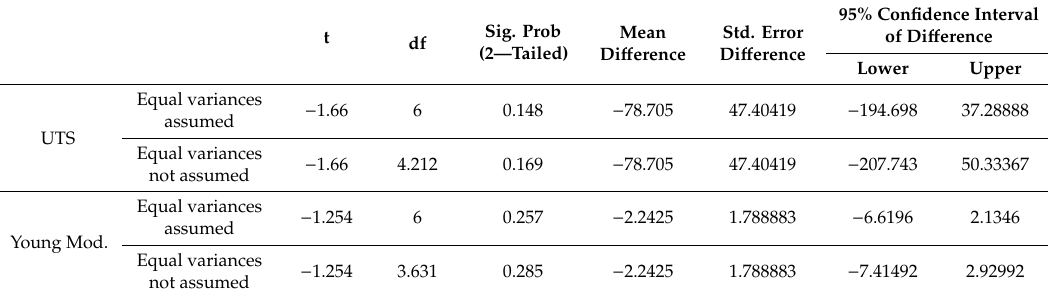
Table A5. T -test for equality of means between sisal and